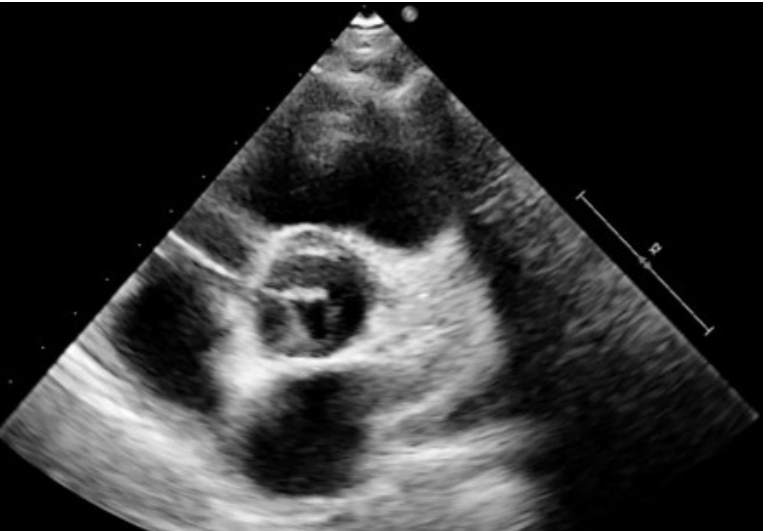
Figure 2. 2D Echocardiography parasternal short axis view (systolic frame) at the level of aortic valve shows an unicuspid aortic valve in a 12-year-old patient.